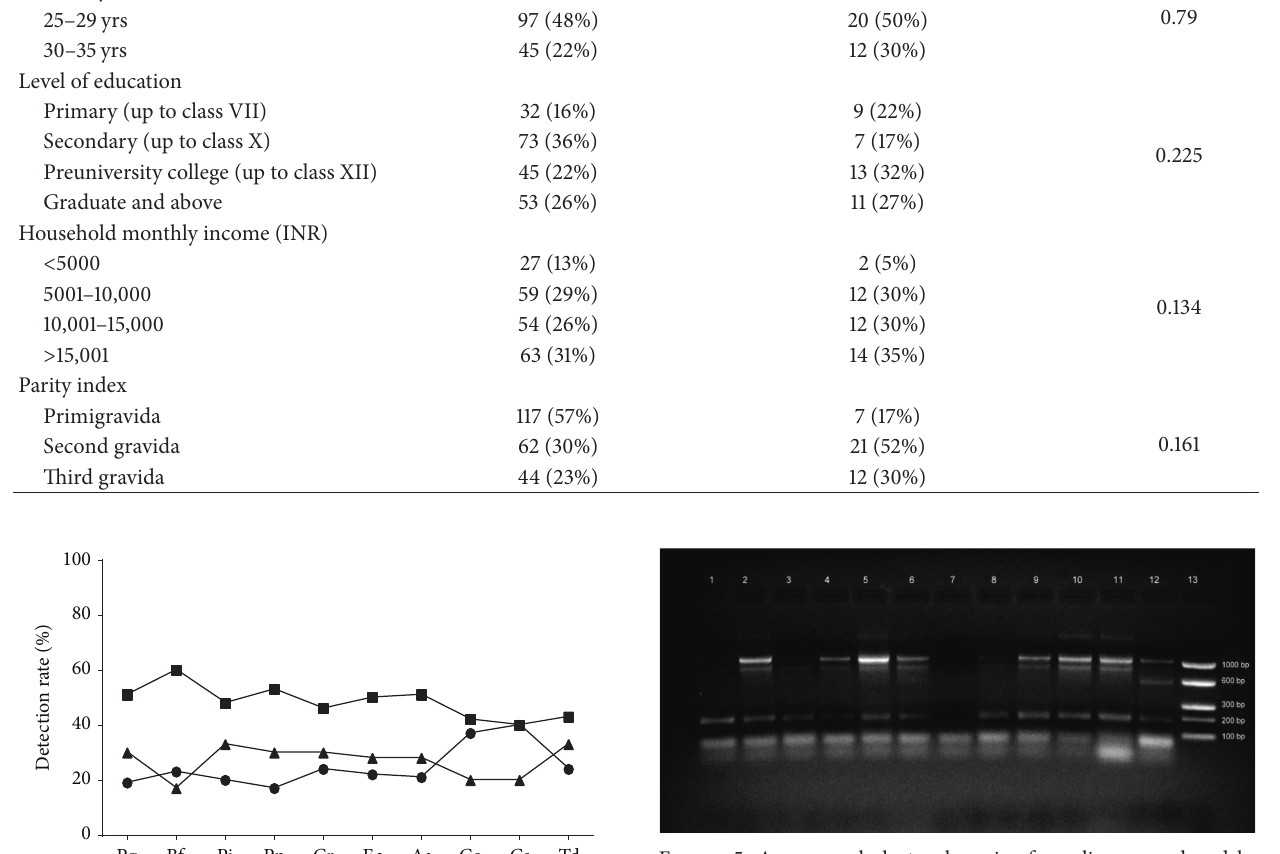
Figure 5: Agarose gel electrophoresis of amplicons produced by PCR II lanes 1, 3, and 8 (Cs); lanes 2, 4, 5, 6, 8, 9, 10, and 11 (Cs and Pn); lane 12 (Cs and Pi); and lane 7 (negative